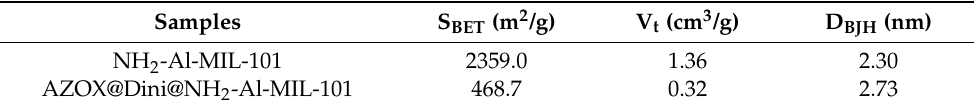
Figure 5. Nitrogen adsorption − desorption isotherms ( a ) and pore size distributions ( b ) of NH 2 -Al-MIL-101 and AZOX@Dini@NH 2 -Al-MIL-101. Table 1. Characterization of mesoporous structure of NH 2 -Al-MIL-101 and AZOX@Dini@NH 2 -Al- MIL-101.